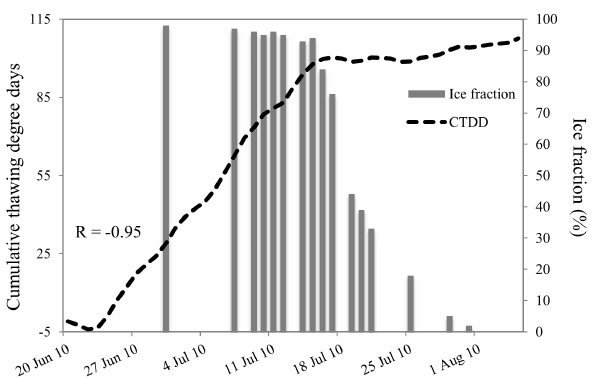
Figure 10. The cumulative thawing degree days and ice fraction for Lake Hazen during the 2010 break-up